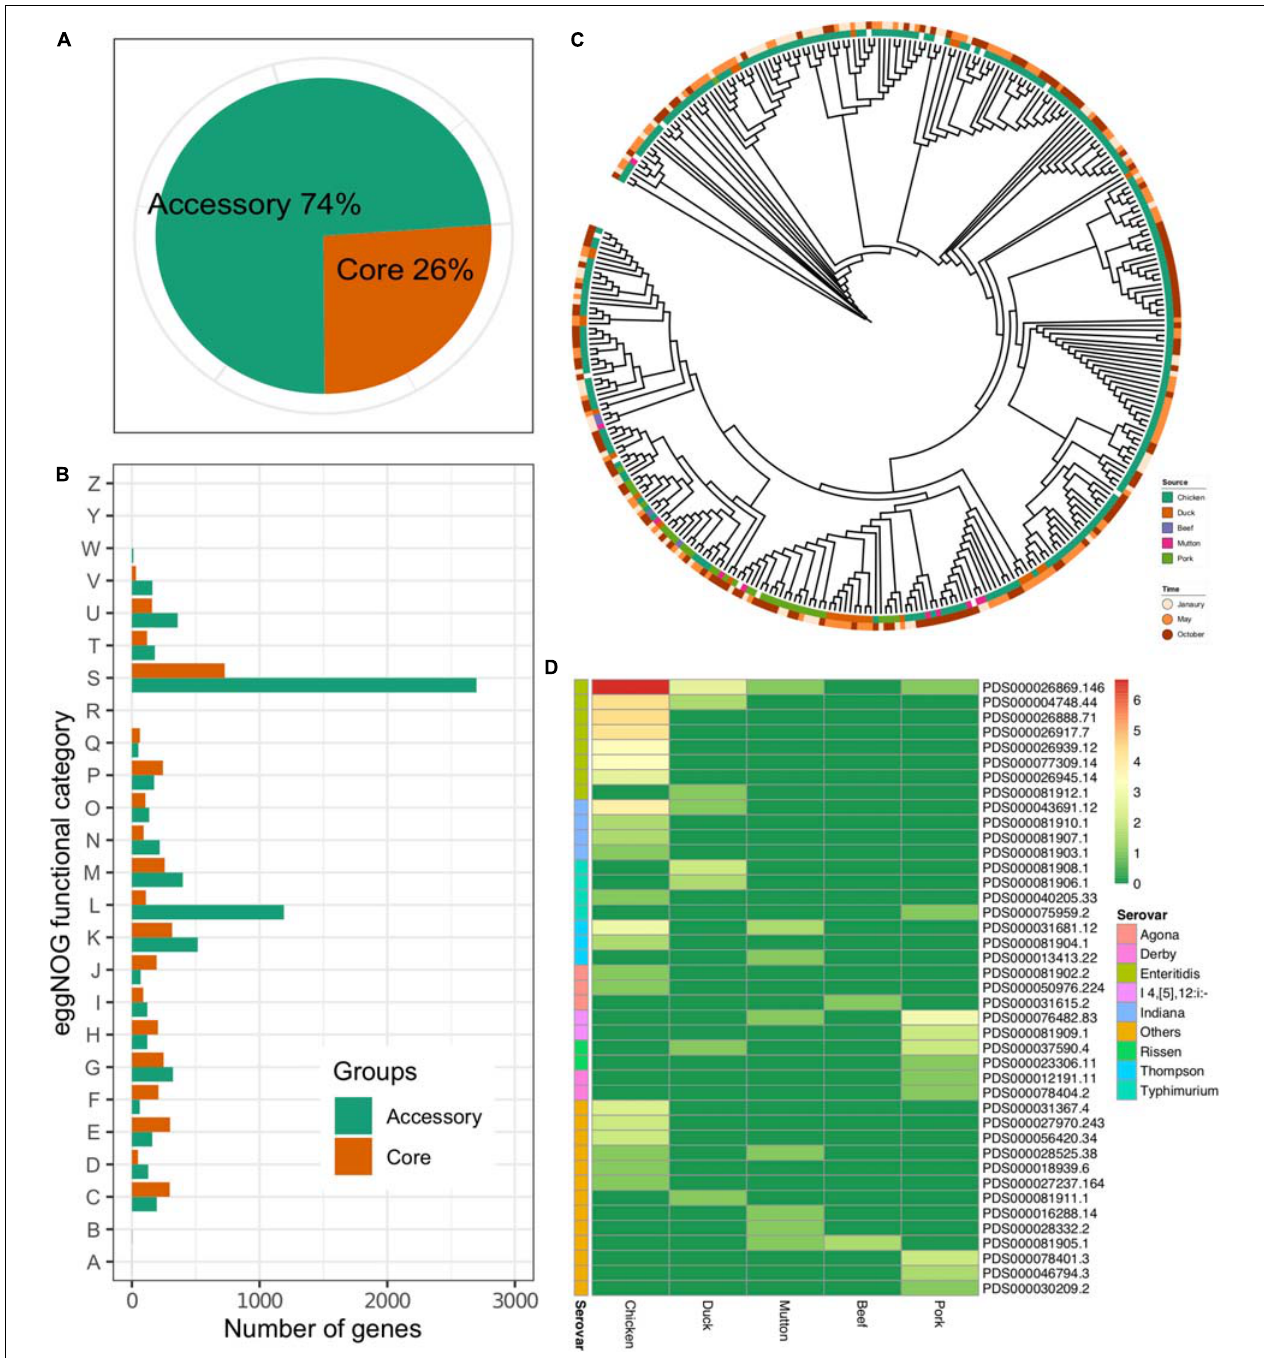
FIGURE 2 | Core genome of Salmonella . (A) Proportions of accessory genes and core genes in the pangenome. (B) Core and accessory genome functional annotation. RNA processing and modification, A; chromatin structure and dynamics, B; energy production and conversion, C; cell cycle control, cell division, chromosome partitioning, D; amino acid transport and metabolism, E; nucleotide transport and metabolism, F; carbohydrate transport and metabolism, G; coenzyme transport and metabolism, H; lipid transport and metabolism, I; translation, ribosomal structure and biogenesis, J; transcription, K; replication, recombination and repair, L; cell wall/membrane/envelope biogenesis, M; cell motility, N; posttranslational modification, protein turnover, chaperones, O; inorganic ion transport and metabolism, P; secondary metabolites biosynthesis, transport and catabolism, Q; general function prediction only, R; function unknown, S; signal transduction mechanisms, T; intracellular trafficking, secretion, and vesicular transport, U; defense mechanisms, V; extracellular structures, W; nuclear structure, Y; cytoskeleton, Z. (C) An ML tree constructed based on the core SNPs ( n = 277,664). (D) Prevalence of the SNP clusters from different sources. Color: the number of the isolates